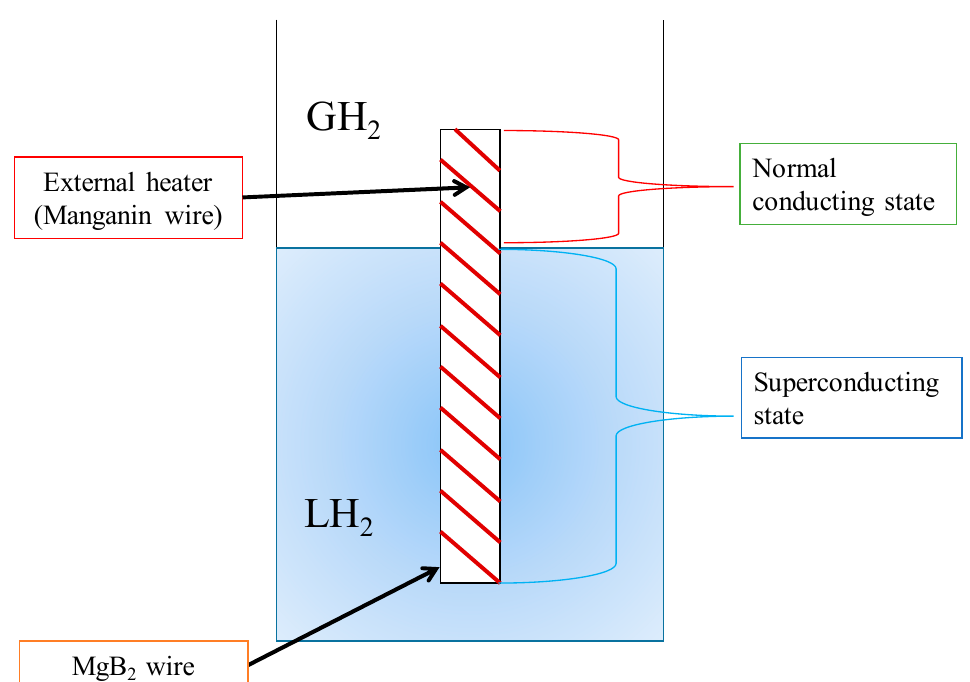
Figure 1. Principle of the external-heating-type MgB 2 level sensor.